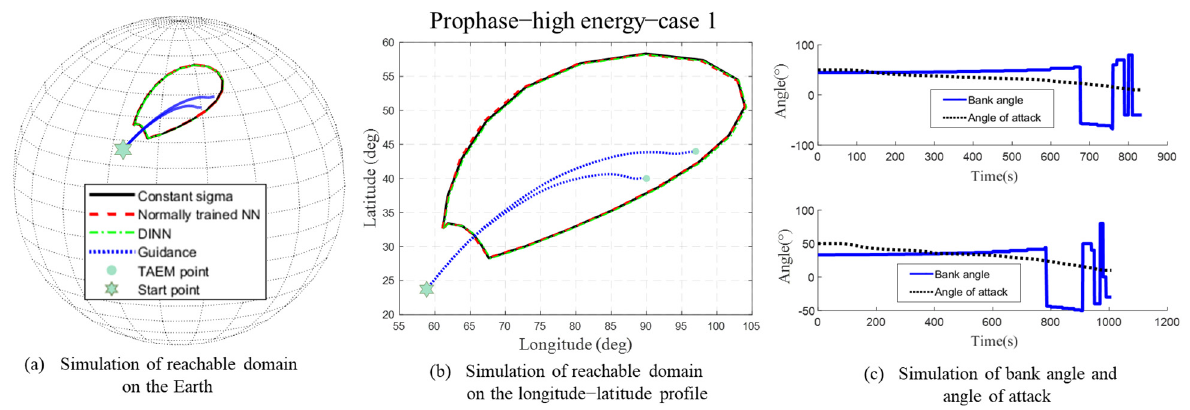
Figure 6. Simulation of high energy Case 1.